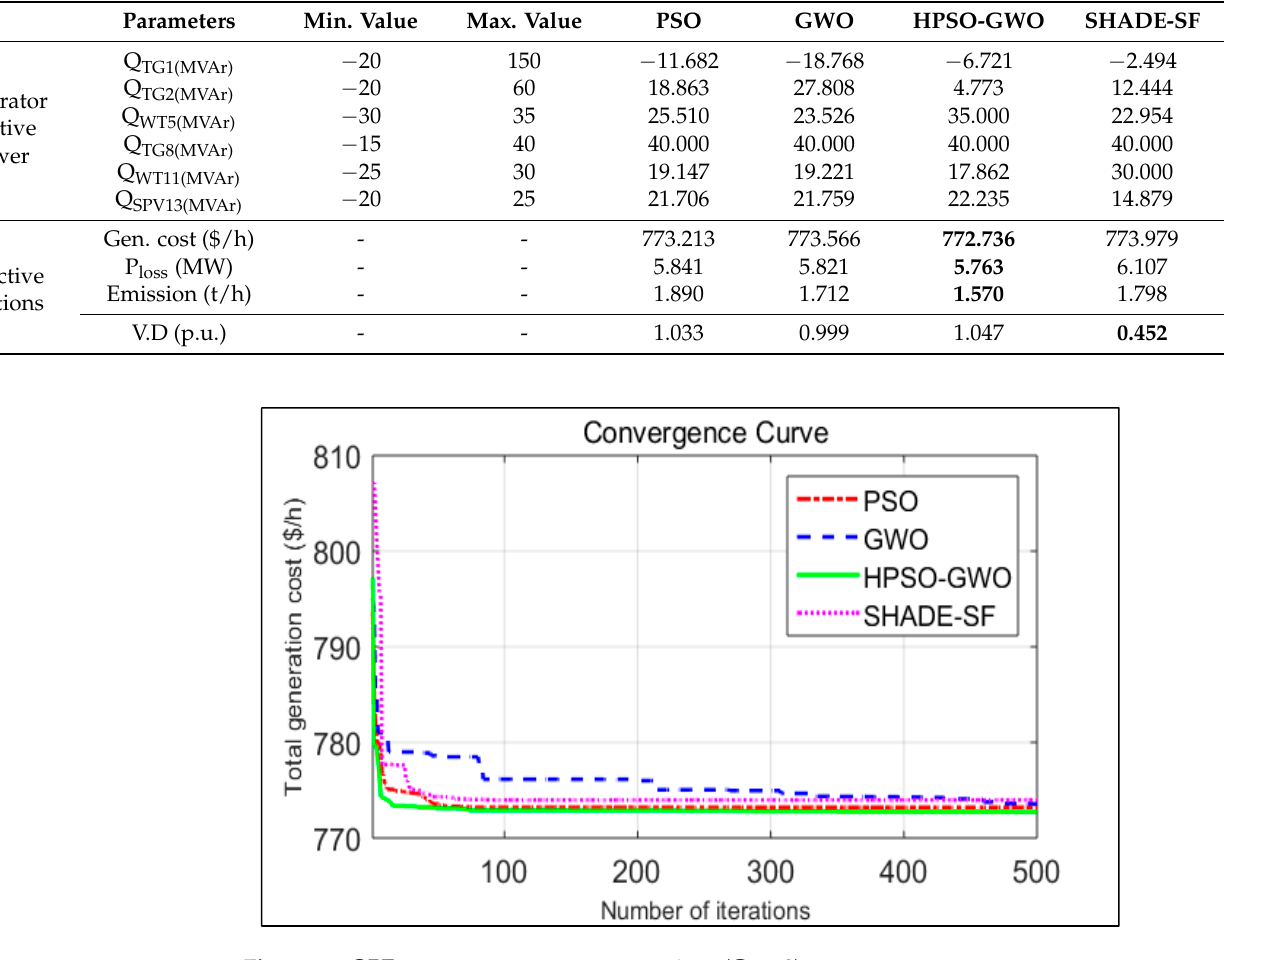
Figure 13. OPF convergence curves comparison (Case 3).